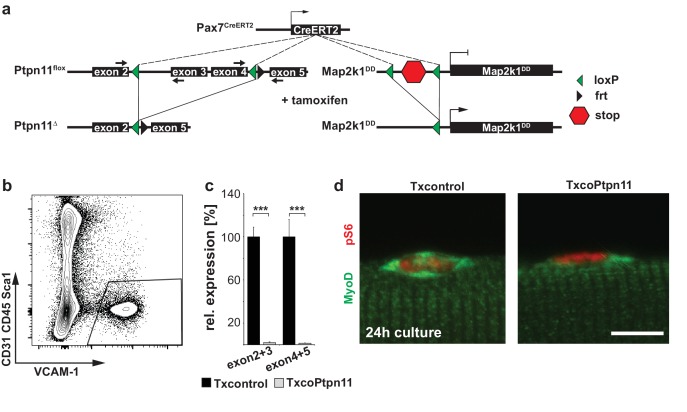
Efficient recombination of the Ptpn11flox allele in adult satellite cells and floating fiber cultures.(a) Genetic strategy used to induce tamoxifen-dependent mutation of Ptpn11 and to activate Map2k1DD expression in adult satellite cells. (b) Gating strategy to isolate VCAM1+ CD31- CD45- Sca1- satellite cells from muscle of adult mice. (c) Relative expression of wildtype Ptpn11 mRNA. The positions of the primers are indicated by small arrows in (a) and they are chosen to exclusively allow the amplification of the unrecombined mRNA by qPCR. (d) Immunostaining of phospho-S6 and MyoD on fibers from Txcontrol and TxcoPtpn11 mice cultured for 24 hr; shown are satellite cells associated with the fiber. n.s. = not significant, *p<0.05, **p<0.01, ***p<0.001. Error bars show S.E.M.